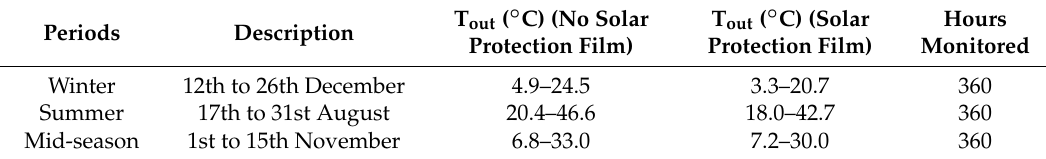
Table 3. Characteristics of periods analysed. Source: Authors.